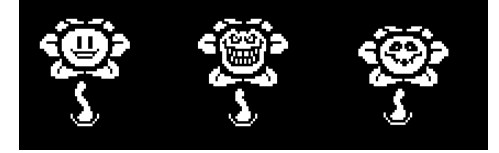
Fig. 4. Sprites in which some small parts are detached. Source: Undertale© game.